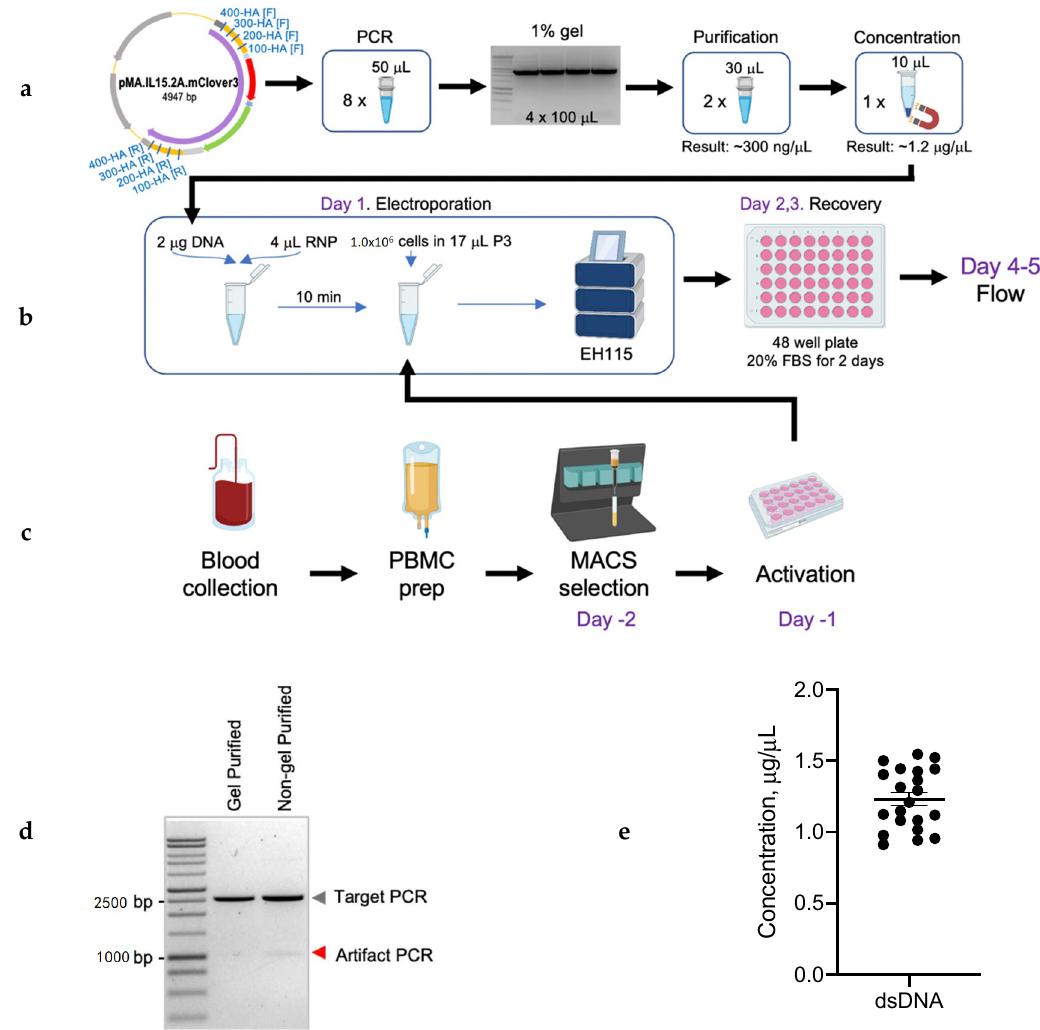
Figure 3. Overview of the steps to generate transgene knock-in in T cell: ( a ) Molecular steps considering vector design, amplification, purification, and concentration DNA. ( b ) Electroporation of RNA ribonucleoproteins (RNPs) and donor template to T cells using Lonza instrument. ( c ) Human T-cell preparation before electroporation. Complete and detailed knock-in protocol can be found in the Supplementary Materials. ( d ) The 1% agarose gel showing PCR amplicons that were gel purified vs. non-gel purified. ( e ) Concentration of dsDNA template after purification and concentration ( n = 24).